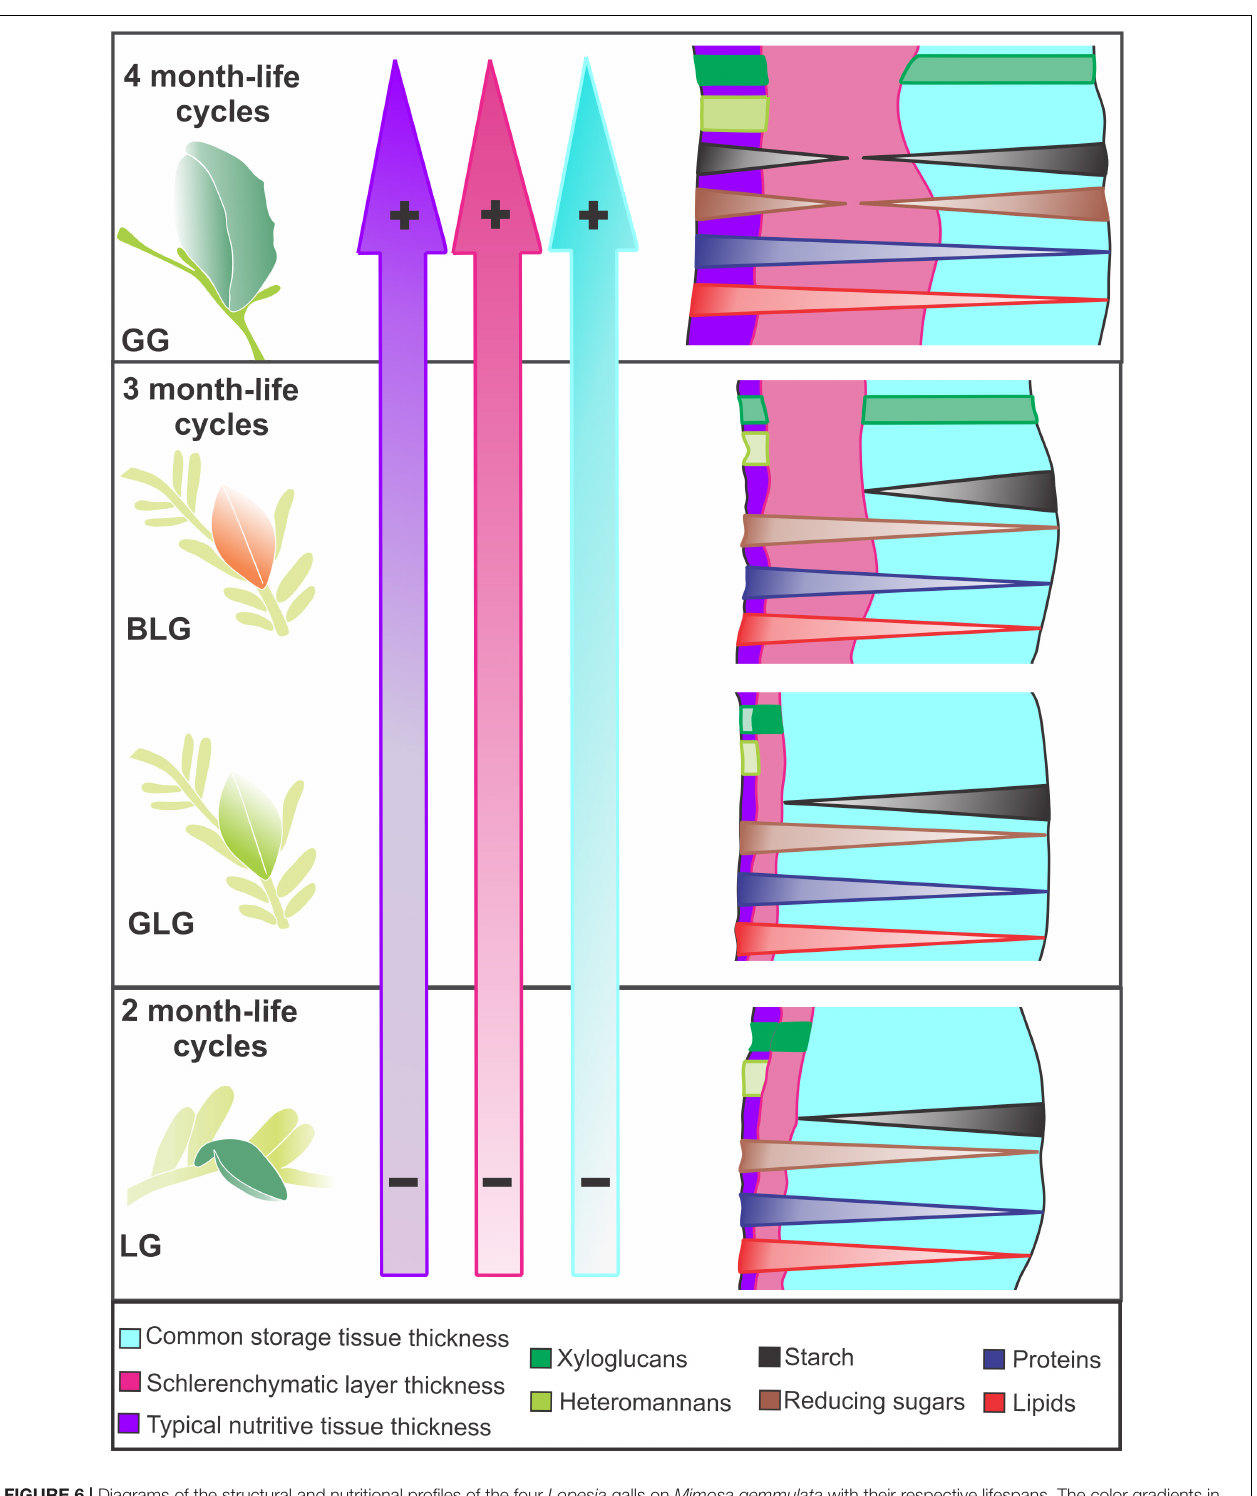
FIGURE 6 | Diagrams of the structural and nutritional profiles of the four Lopesia galls on Mimosa gemmulata with their respective lifespans. The color gradients in the purple, pink and blue arrows, and the symbols (– and +) indicate tissue thickness investment. The diagrams of the transverse sections illustrate the gradients of the nutritive molecules in gall tissues. BLG, brown lanceolate bivalve-shaped gall; GG, globoid bivalve-shaped gall; GLG, green lanceolate bivalve-shaped gall; LG, lenticular bivalve-shaped gall.